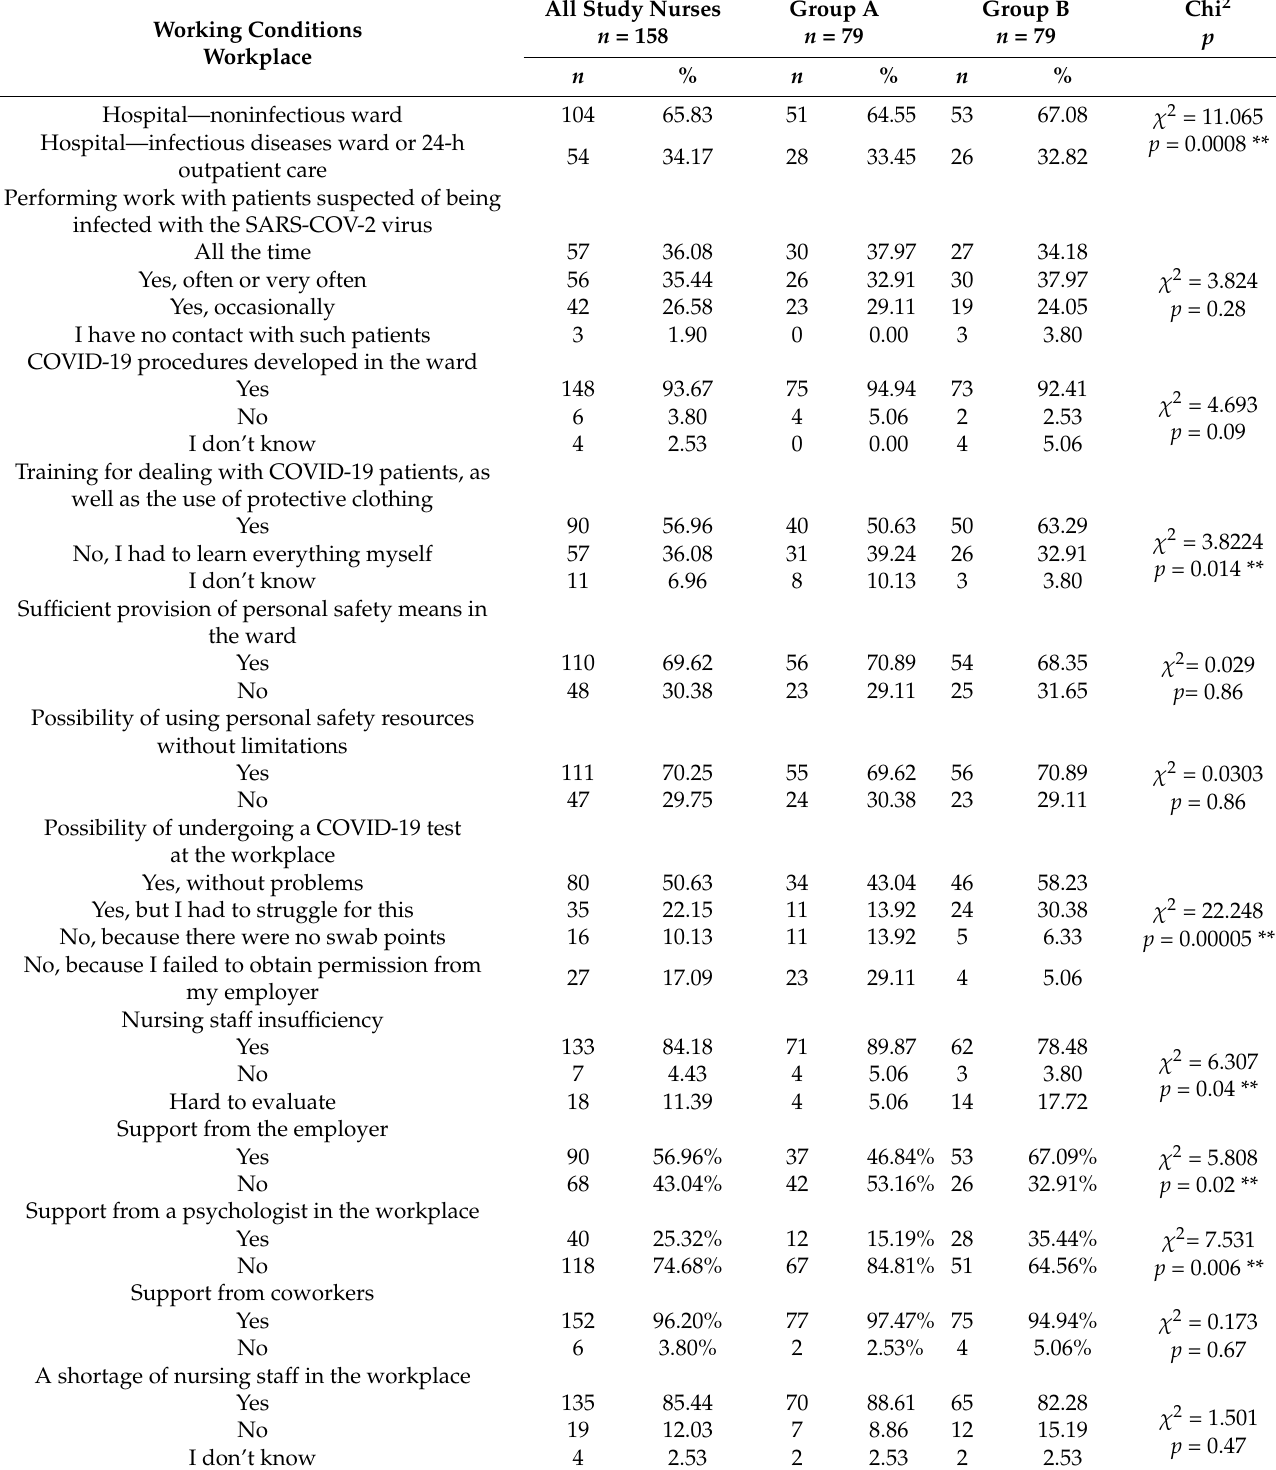
Table 5. Correlation between COVID-19 infection among nurses and workplace